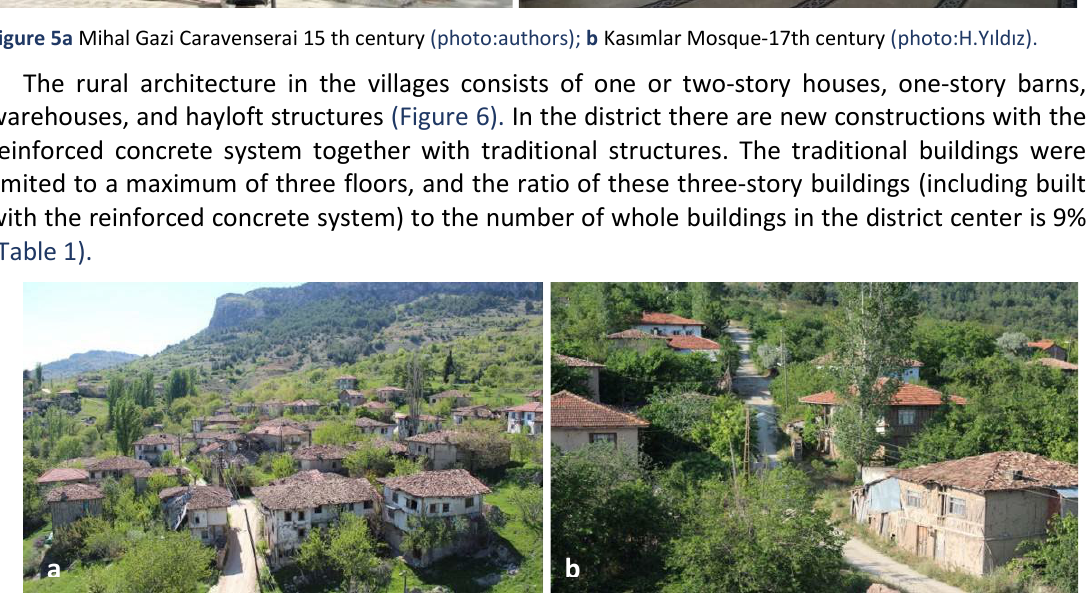
Figure 6 a Büyükbelen Village; b Keskin Village (photo:authors).